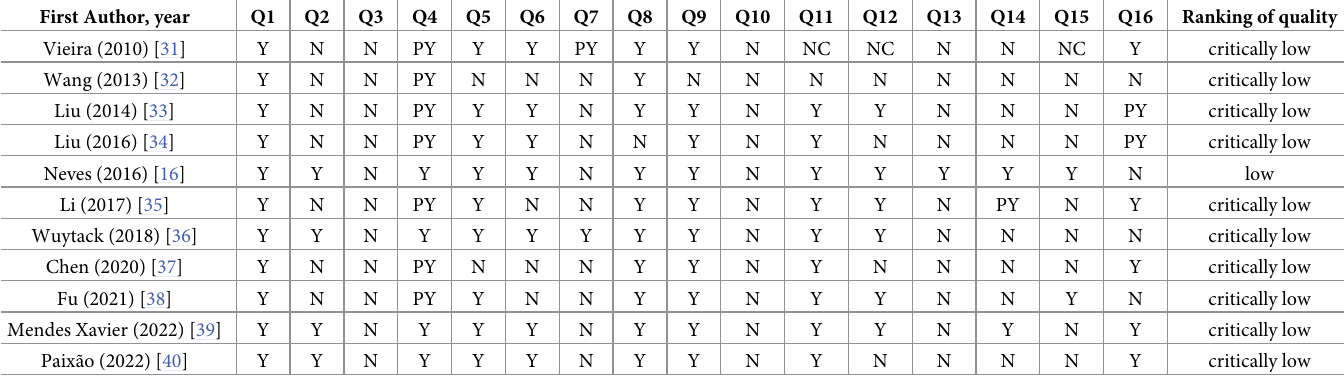
Table 2. Result of the AMSTAR-2